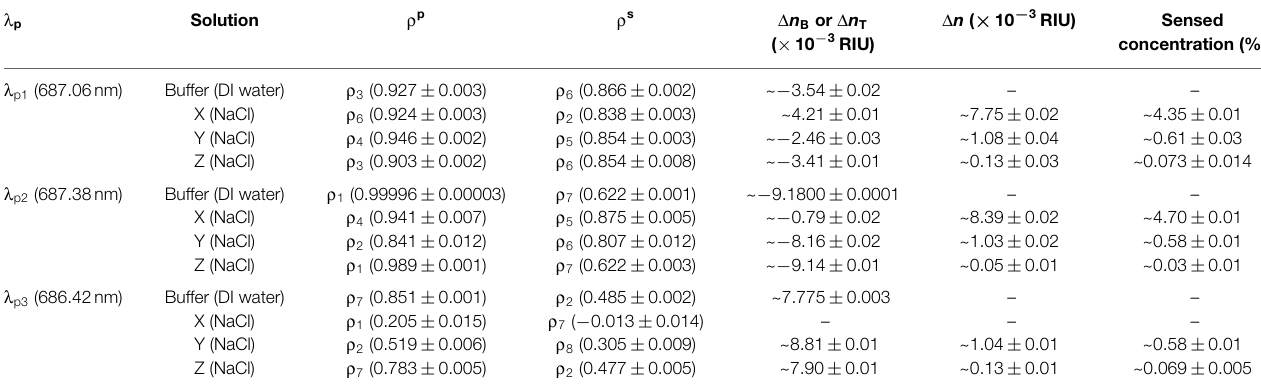
TABLE 1 | Sensing results at the three probe wavelengths upon the buffer solution and the three test solutions . λ p